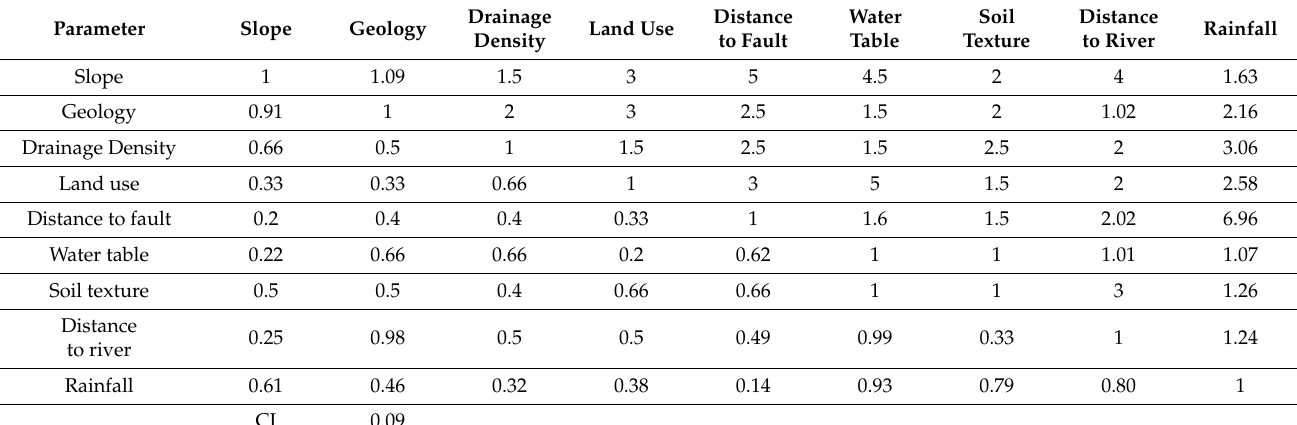
Table 3. Pairwise comparison matrix of